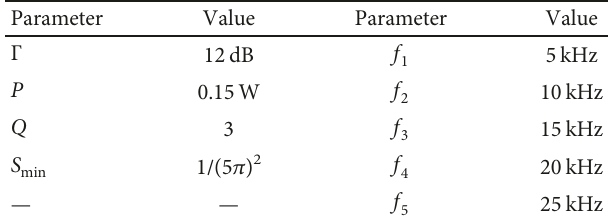
Figure 8: The relative distance between any modules within 244 days. Table 2: Parameters for numerical